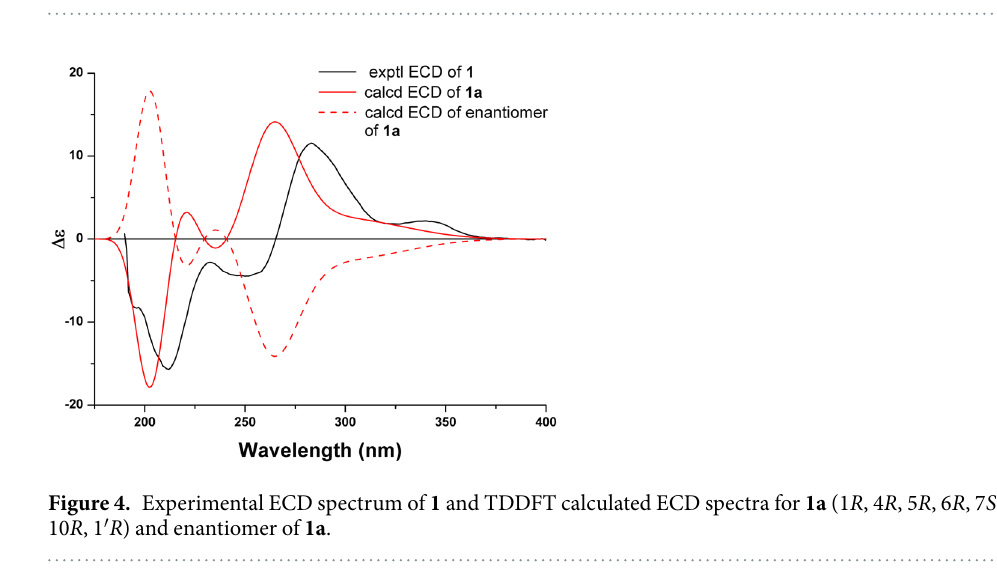
5 Scientific RepoRts | 7: 1047 | DOI:10.1038/s41598-017-01028-4